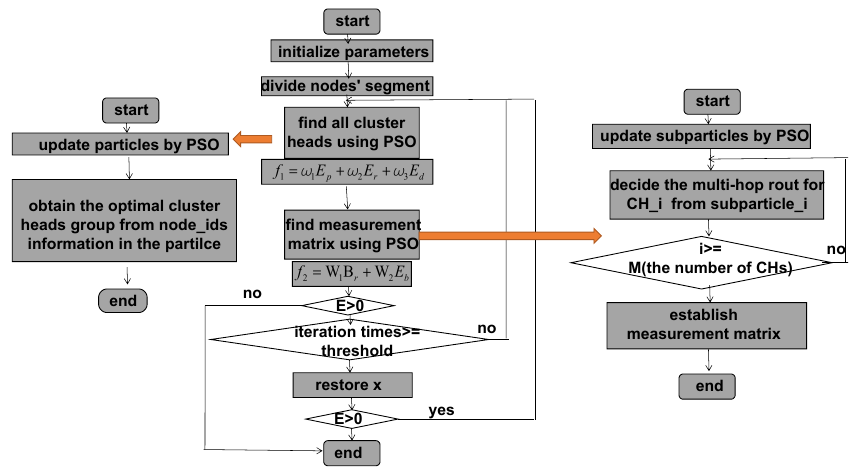
Figure 4. The flowchart of proposed